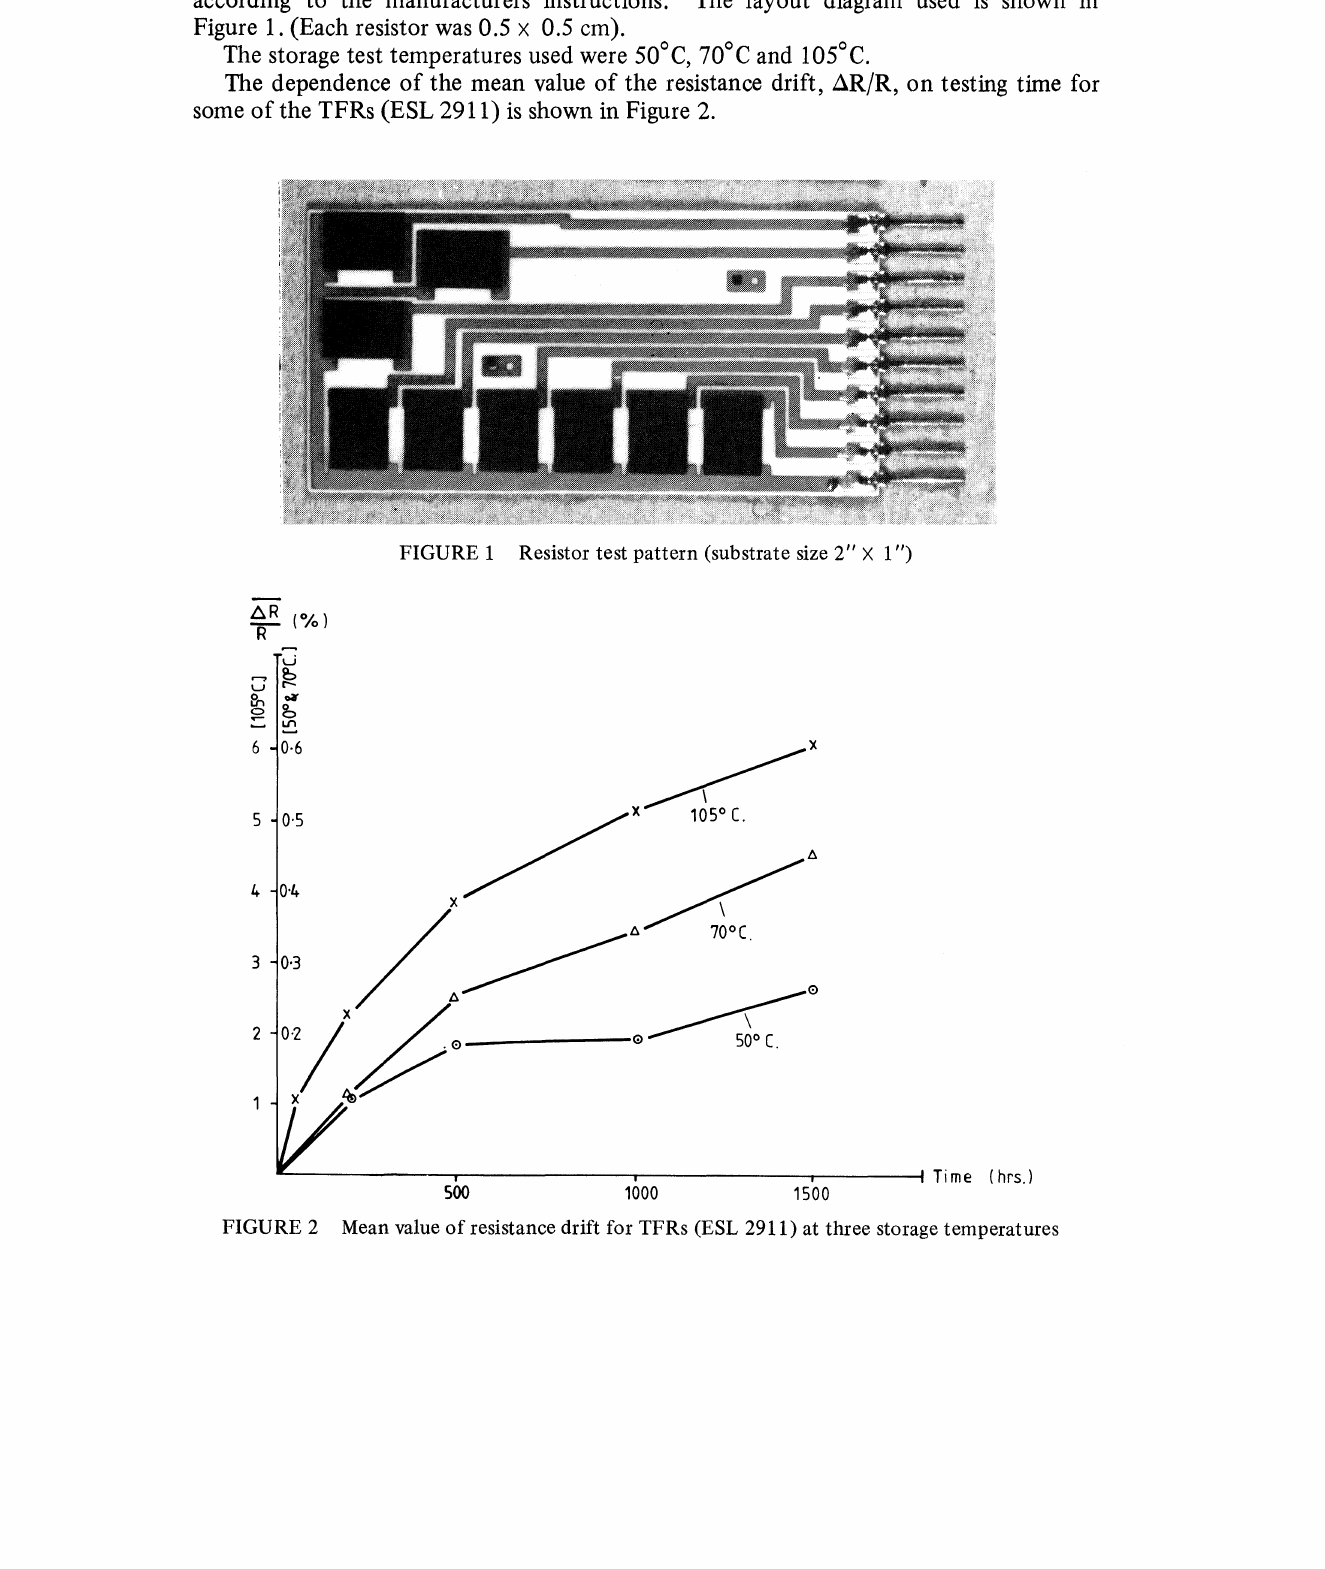
Resistor test pattern (substrate size 2" X 1")